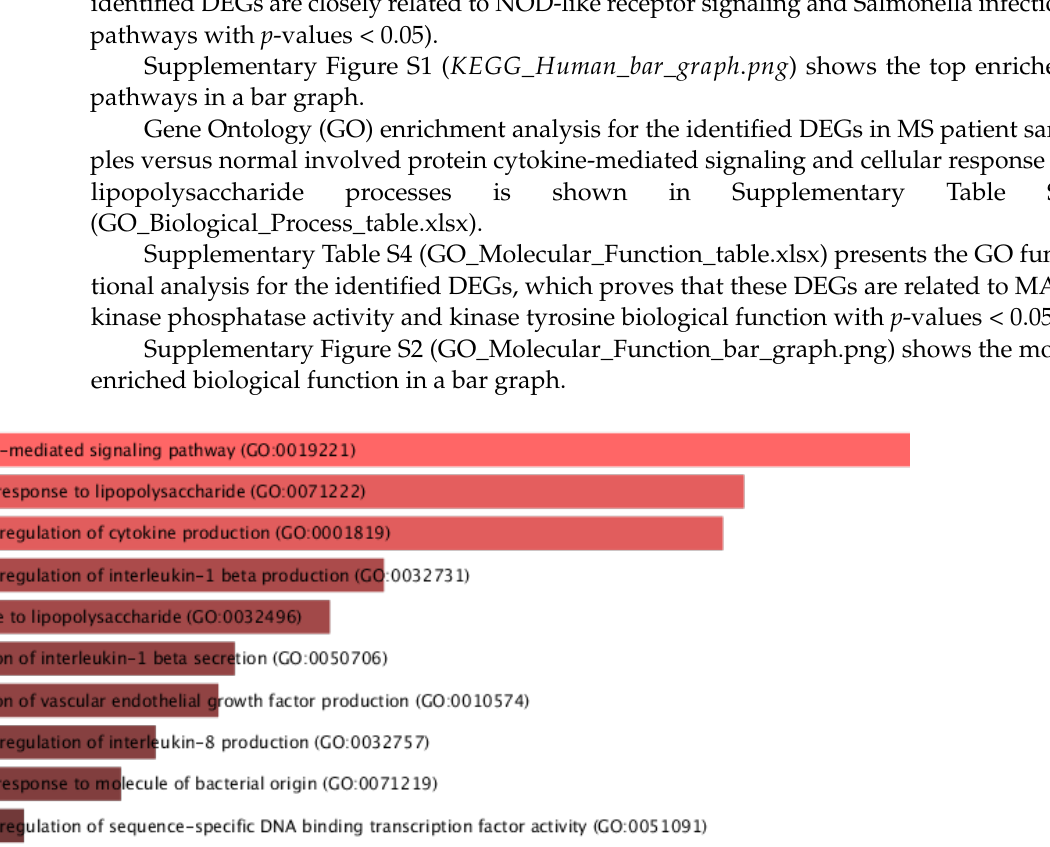
Figure 6. Enriched Gene Ontology terms in the identified